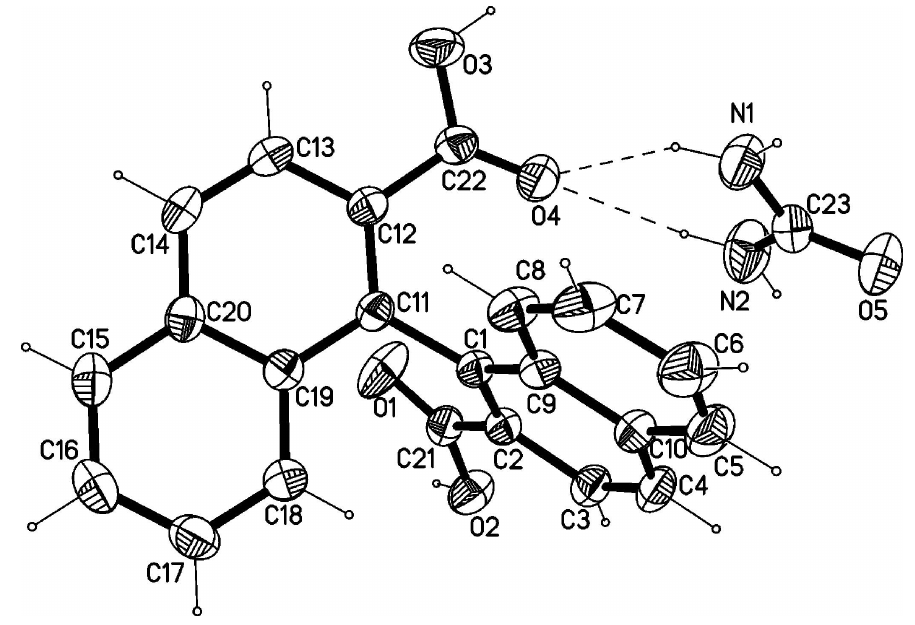
Figure 1 Perspective view of the asymmetric unit showing 40% probability displacement ellipsoids for the non-H atoms. Dashed lines represent hydrogen bonds.